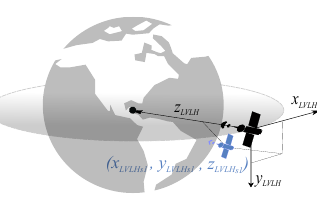
Figure 1. Local-vertical, local horizontal (LVLH) coordinate system with x-axis tangential to flight direction along the satellite’s orbit, z-axis towards Earth center and y axis completing the right-handed coordinate